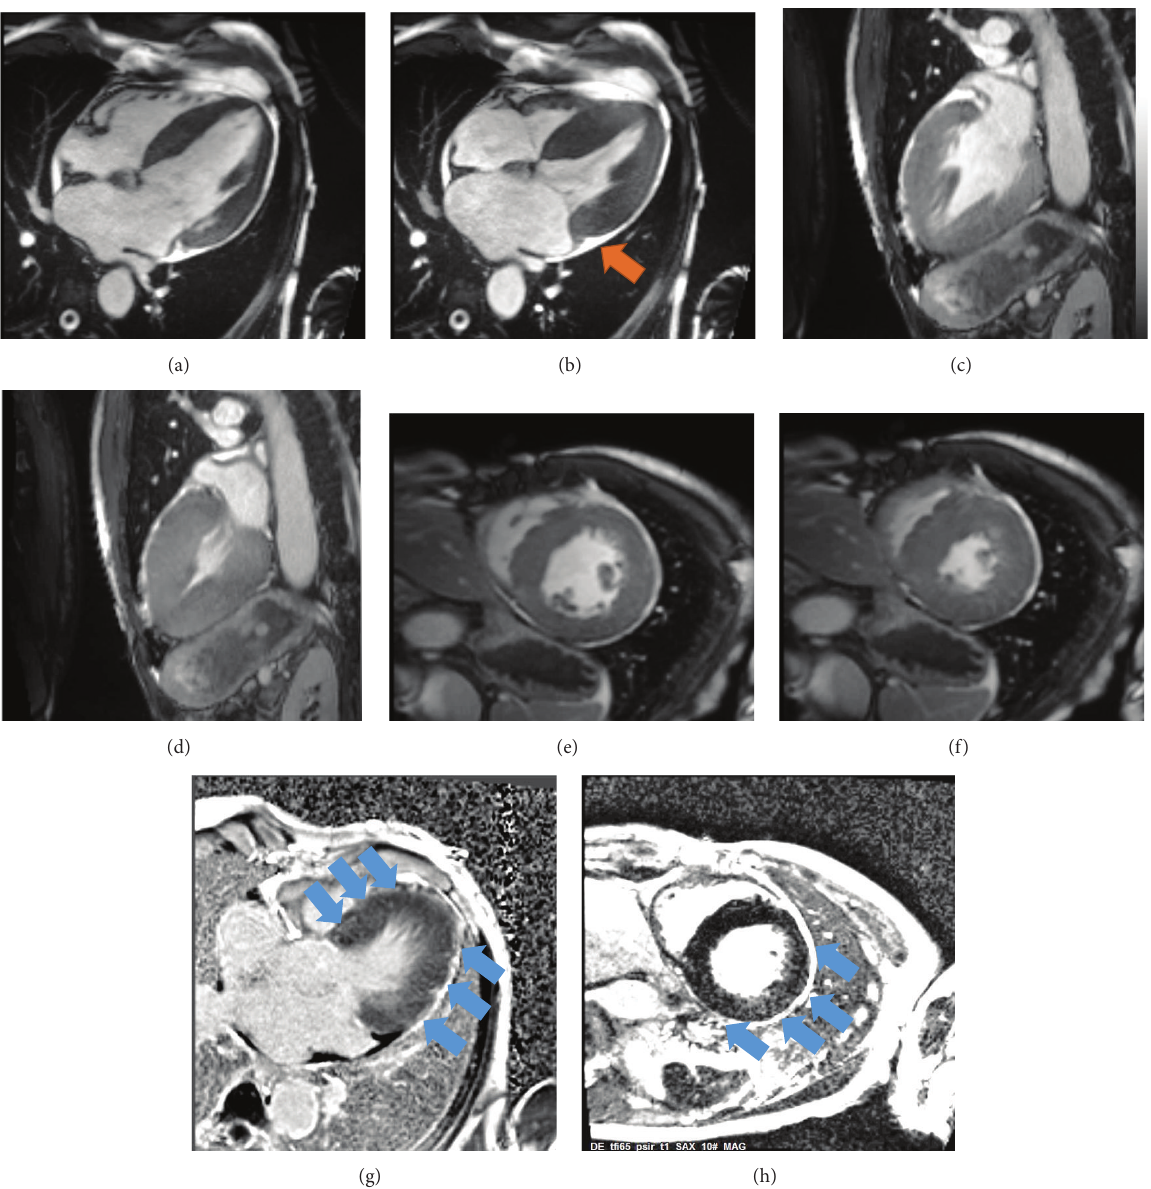
Figure 2: Cardiac magnetic resonance imaging confirmed severe left ventricular hypertrophy and minimal pericardial effusion ((a)–(f), orange arrow in (b)). Late gadolinium enhancement was suspected in corresponding 4-chamber and short axis view images